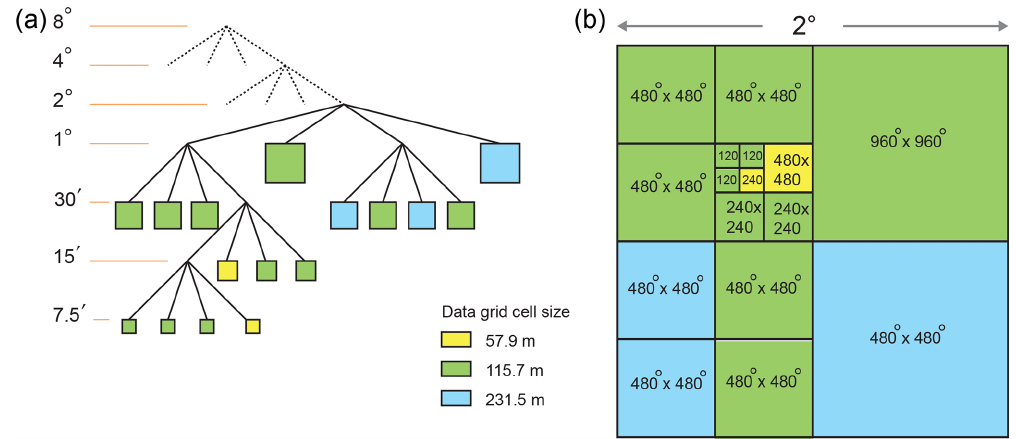
Figure 2. (a) An example of a quadtree metagrid tree structure with a 2 ◦ subsection color coded to illustrate different data grid resolutions in meters. (Note that a 960 × 960 grid subtending 1 ◦ would have a grid cells size of 115.7m.) (b) The same subsection is shown as a map. Numbers in the square areas illustrate grid sizes used to achieve different spatial